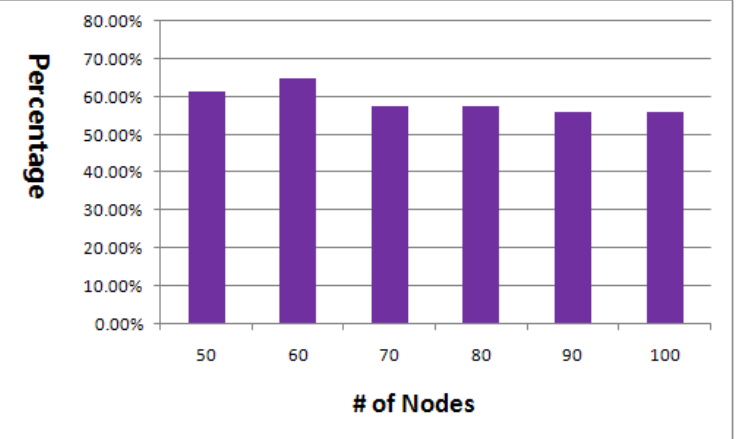
Figure 5. Ratio of obtained relation information after the first basic